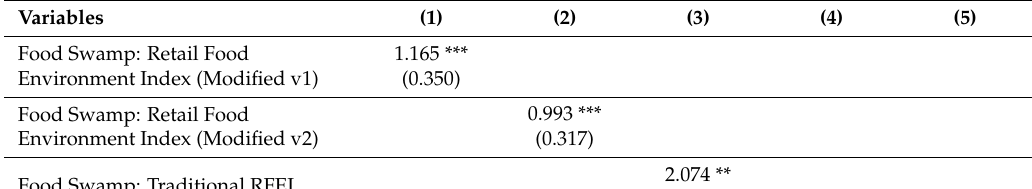
Table A5. 2SLS (IV) coefficient estimates of food swamps on obesity